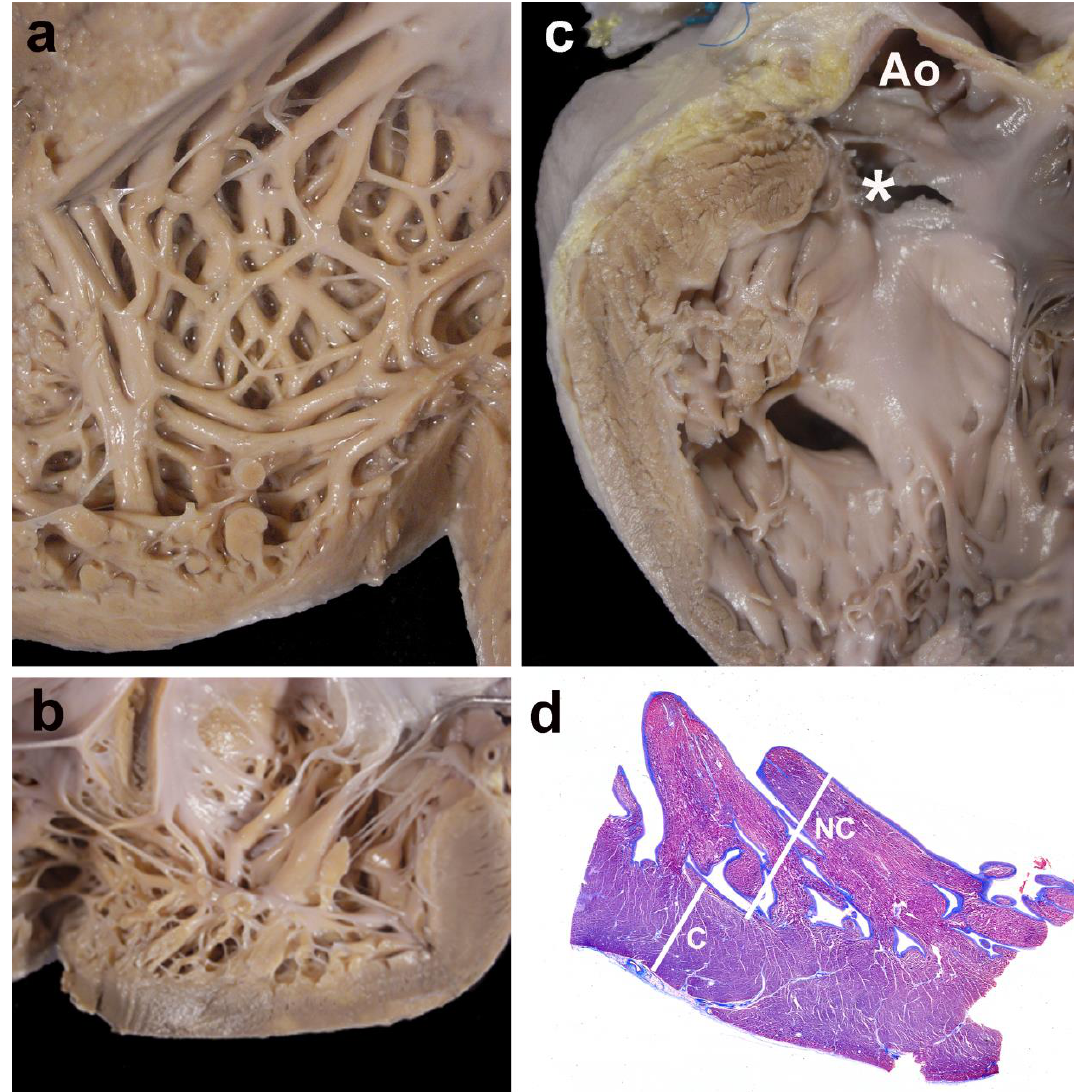
Figure 4. Gross and histological morphology. Four examples of cases showing focal non-compaction of the left ventricle. ( a ) and ( b ) Left ventricular wall of two cases with Ebstein’s anomaly of the tricuspid valve. The apical regions show a thick noncompacted layer when compared to the compacted myocardium. In ( c ), a case with a muscular trabecular ventricular septal defect shows a focal area of noncompaction at the left ventricular outlet free wall (* the membranous septum has been accidentally torn, but was originally intact); Ao—opened aorta. Panel ( d ) depicts the histological aspect of the apical region of a case with complete transposition of the great arteries, although histology was not used for measurements. The noncompacted layer (NC) is thicker than the compacted myocardium (C); Masson´s trichrome stain.